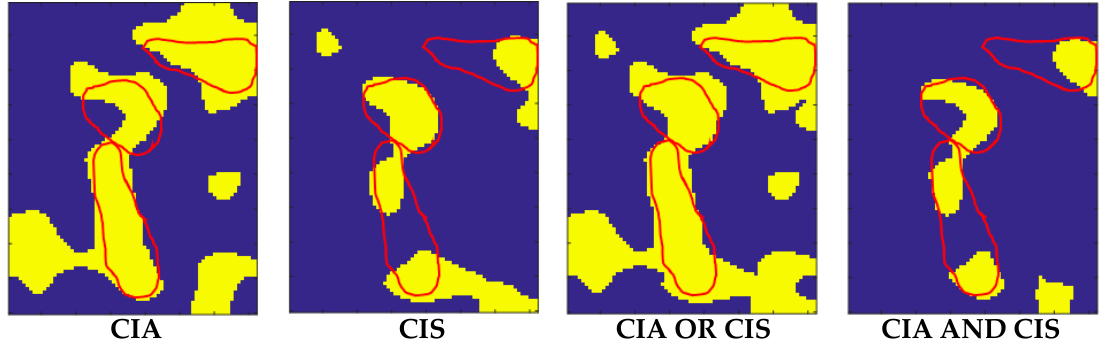
CIS CIA OR CIS CIA CIA AND CIS CIS CIA OR CIS CIA CIA AND CIS Figure 9. From left to right: CIA, CIS, OR-logic and AND-logic maps for liver sample #1. The Figure 9. From left to right: CIA, CIS, OR-logic and AND-logic maps for liver sample #1. The dimension Figure 9. From left to right: CIA, CIS, OR-logic and AND-logic maps for liver sample #1. The Figure 9. From left to right: CIA, CIS, OR-logic and AND-logic maps for liver sample #1. The dimension of the scanned area was 24 × 30 mm 2 . The total number of scanned points in the of the scanned area was 24 × 30 mm 2 . The total number of scanned points in the investigated area was dimension of the scanned area was 24 × 30 mm 2 . The total number of scanned points in the dimension of the scanned area was 24 × 30 mm 2 . The total number of scanned points in the investigated area was n = 180. n = 180. investigated area was n = 180. investigated area was n = 180.